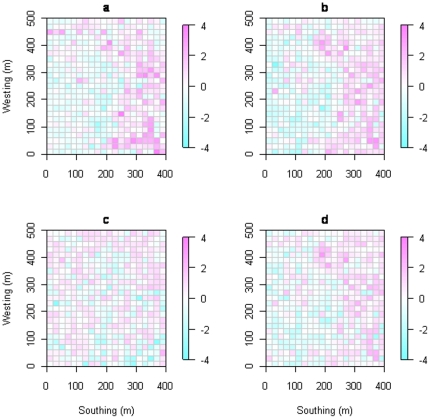
The spatial patterns of NRI and NTI values in the forest plot.Values of NRI and NTI for each 400 m2 quadrat in the 20-ha forest dynamics plot in Dinghushan, south China, are calculated using the molecular phylogeny and the Phylomatic phylogeny. Negative NRI and NTI values indicate phylogenetic overdispersion and positive values indicate phylogenetic clustering. The color scales across all NRI and NTI maps are made equivalent to allow for direct visual comparisons between the four maps. a. Barcode NRI; b. Phylomatic NRI; c. Barcode NTI; d. Phylomatic NTI